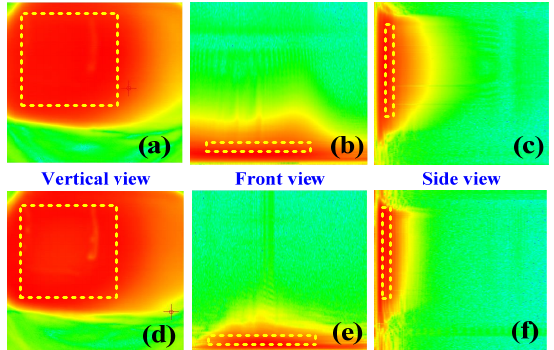
Figure 20. Frequency-domain imaging for the synthetic testing sample [75]. ( a – c ) Three-view imaging results at 0.348 THz; ( d – f ) Three-view imaging results at 0.476 THz. Reprinted/adapted with permission from Ref. [75]. 2022, IEEE Transactions on Transportation Electrification.